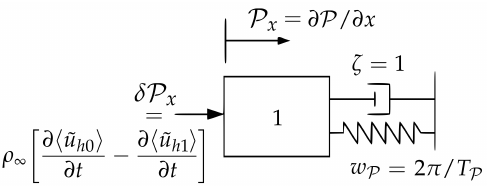
Figure 2. The Mass-Spring-Damper system ruling the evolution of the longitudinal pressure gradient P x = ∂ P / ∂ x , according to Equation